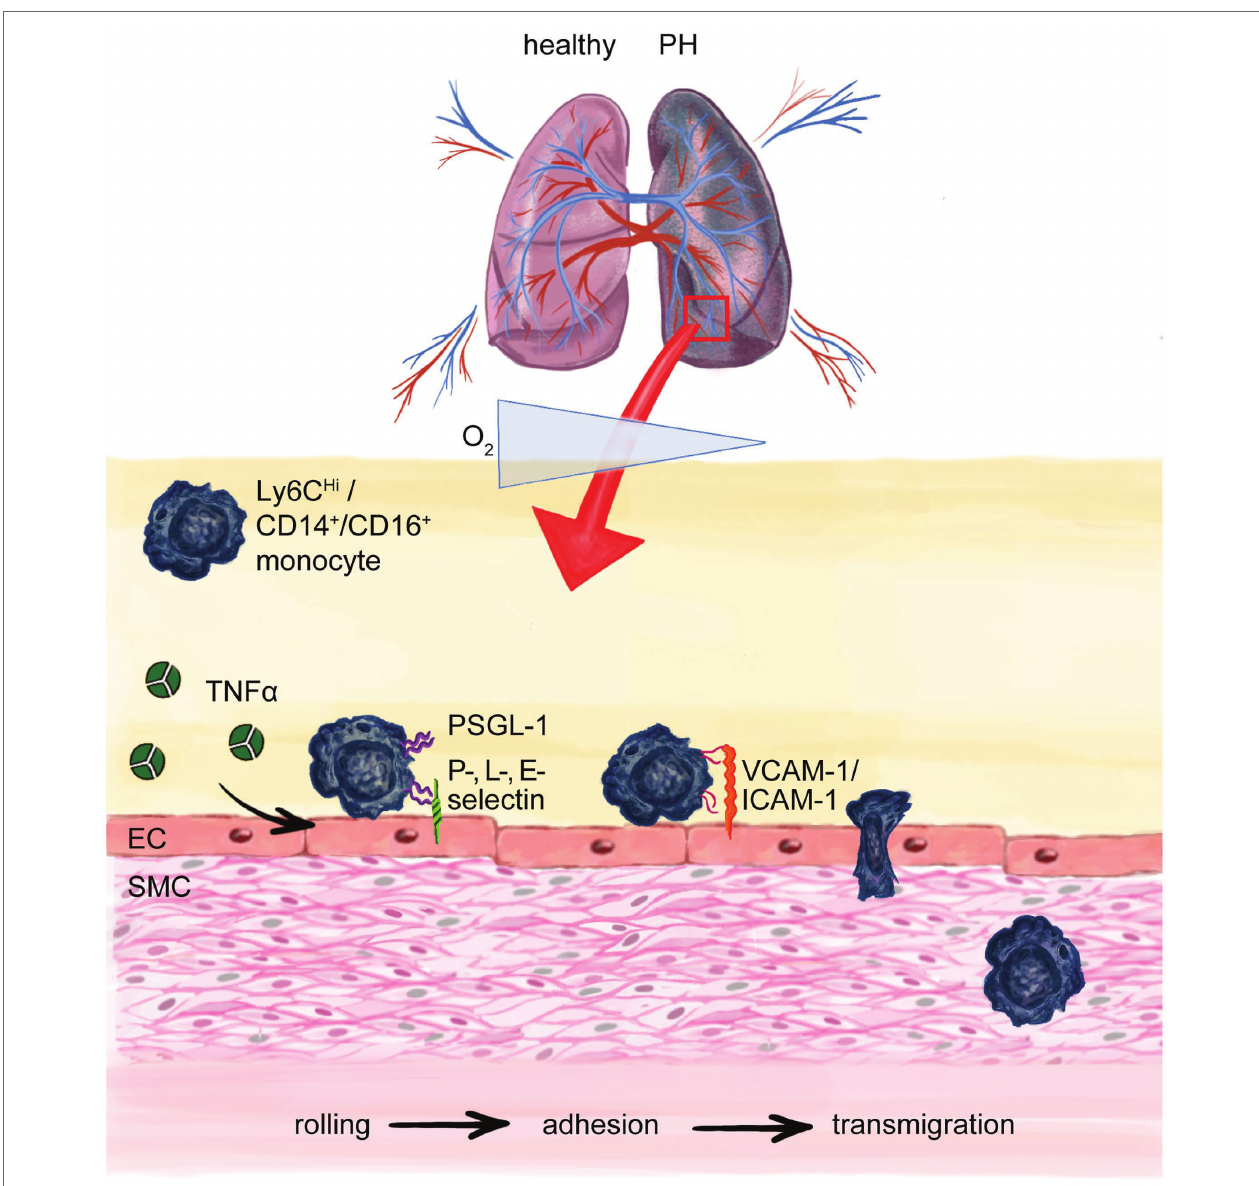
FIGURE 3 | Monocyte transmigration to the site of injury and perivascular inflammation in pulmonary hypertension (PH). Chronic hypoxia in PH recruits monocytes to the lung. Cytokines like Tumor necrosis factor- α (TNF- α ) cause upregulation of adhesion molecules on endothelial cells (ECs) e.g. P, L-, E-selectin which interact with P-selectin glycoprotein ligand-1 (PSGL-1) on especially murine pro-inflammatory Ly6C Hi monocytes (correspond to human CD14 + , CD16 − pro-inflammatory monocytes) enabling the process of rolling on and attaching to the endothelium with following integrin mediated adhesion to, e.g., ICAM-1 or VCAM-1 and finally paracellular transmigration. Intercellular adhesion molecule-1 (ICAM-1); vascular cell-adhesion molecule-1 (VCAM-1); smooth muscle cell